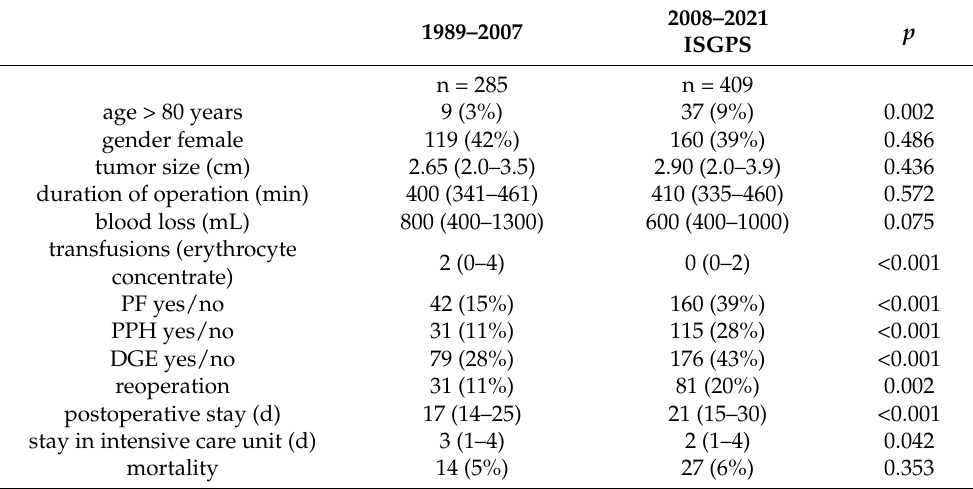
Table 5. Comparison between 1989–2007 and 2008–2021 (Implementation